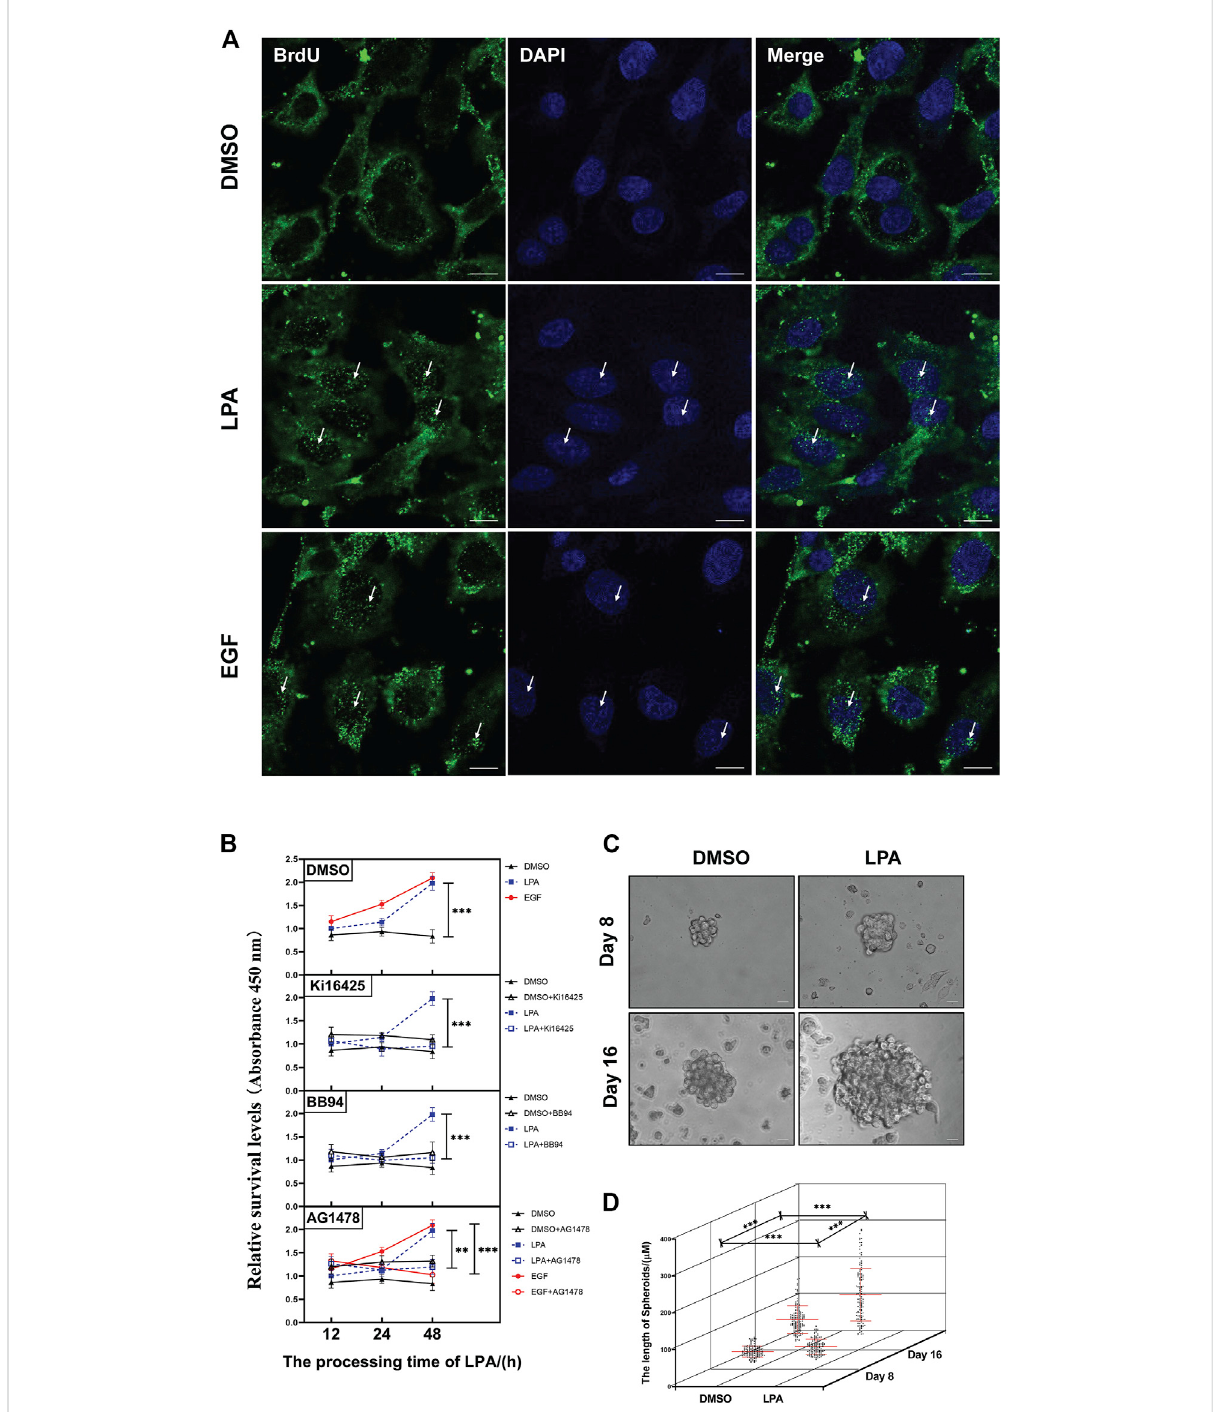
FIGURE 4 LPA signal mediates DNA replication, cell-cycle progression, and cell proliferation of HGSOC cells. (A) Representative images of immunolluorescence staining with anti-BrdU (green) and DAPI/nuclei (blue). Some increased green puncta in the nucleus are identi fi ed with white arrows. OVCAR5 cells. Scale bar 10 μ m. All images were obtained with the same acquisition conditions. (B) The cell proliferation of OVCAR5 cells. Cells were pretreated with speci fi ed inhibitors for 30 min and then grown in 0.1% DMSO, 10 µM LPA or 10 ng/ml EGF. Mean ± SEM, n = 3, VNOVA, Dunnett ’ s multiple comparison test, ** p < 0.01, *** p < 0.001. (C) Representative phase-contrast images of bioreactor expanded OVCARS cells at indicated days of cultivation. Scale bar 20 μ m. (D) Graphical illustration of the average aggregate size measured at the indicated day of cultivation. Day 8, DMSO n = 140, LPA n = 139; Day 16, DMSO n = 153, LPA n = 138. Images were analyzed using Nikon NIS Elements D software, mean ± SD, Student ’ s unpaired t -test, *** p <